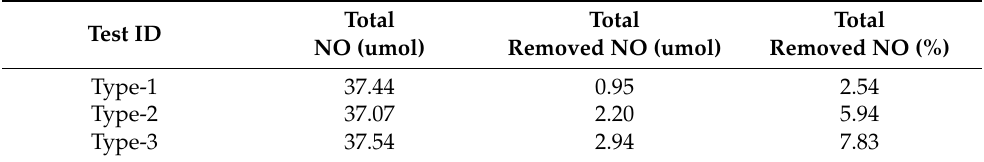
Figure 9. Variation of NOx concentrations on the surface treated asphalt specimen during the mixed tank photo reactor experiment. Table 8. NO reduction and reduction efficiency on the surface treated asphalt specimen of mixed tank photo reactors.